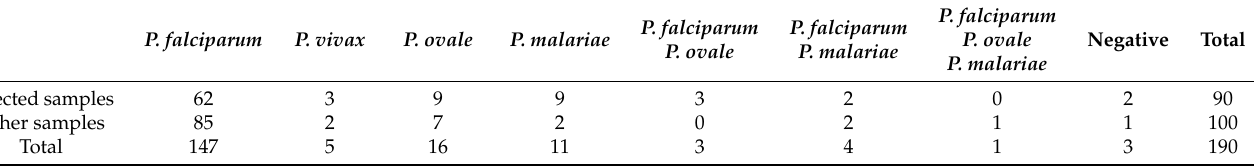
Table 1. Identification of Plasmodium species of the 190 samples by homemade real-time